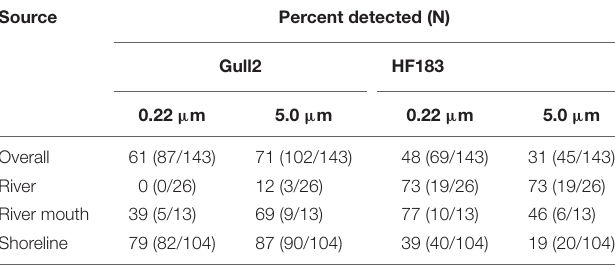
TABLE 2 | Detection rates of Gull2 and HF183 host-specific MST markers in samples by filter pore size (0.22- and 5.0- µ m) and water source [% detected includes samples within range of quantification (ROQ) and detected but not quantifiable